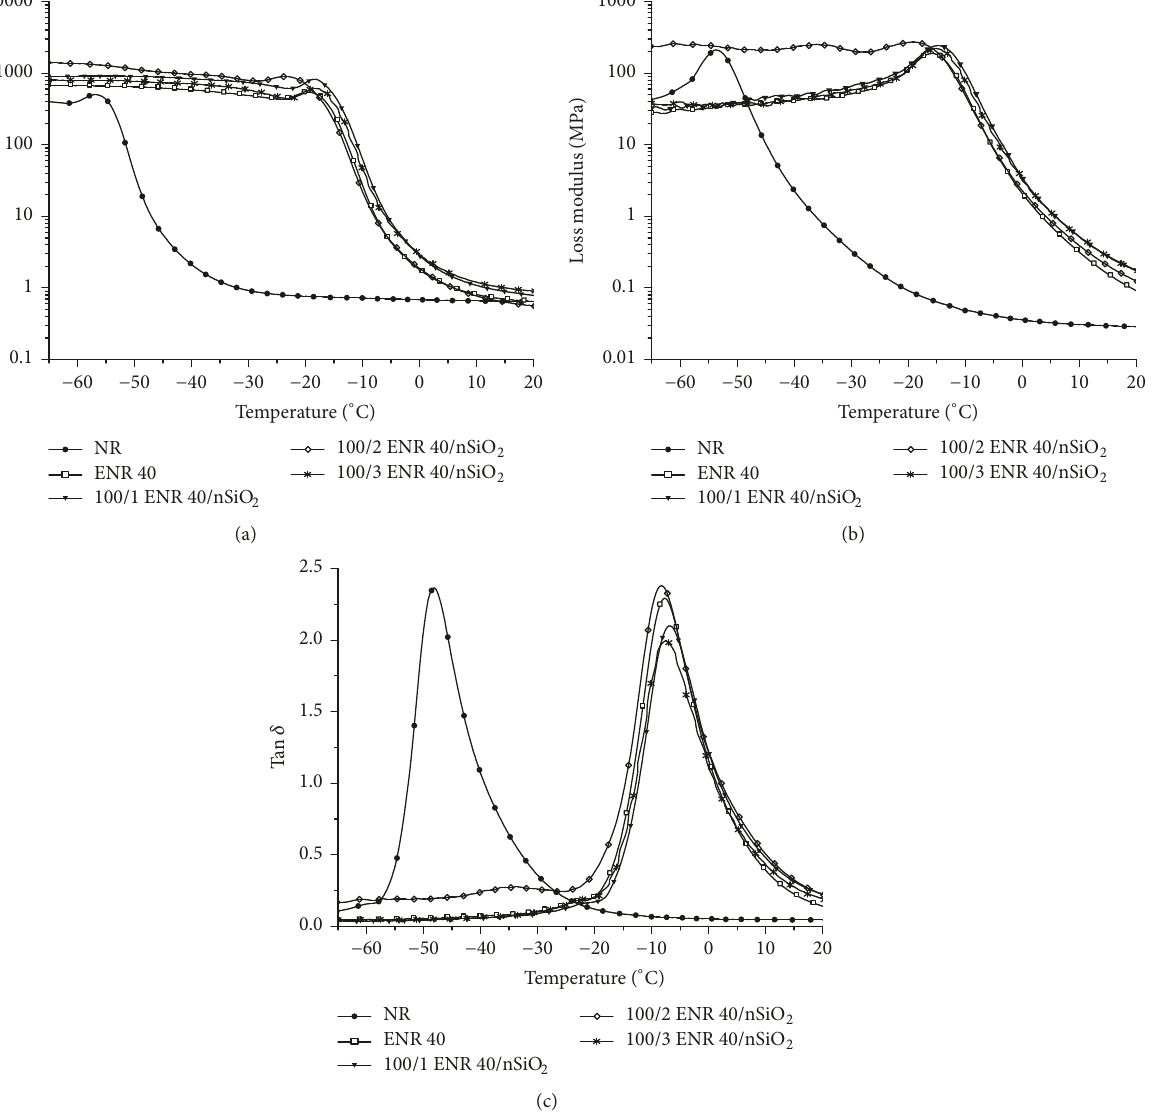
Figure 6: Dynamic mechanical properties of NR, ENR 40, and ENR 40/nSiO 2 nanocomposites in terms of (a) storage modulus, (b) loss modulus, and (c) tan 𝛿